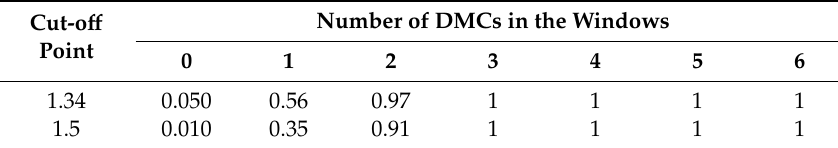
Table 3. Proportions of Bayes factors that fell above the cut-off.